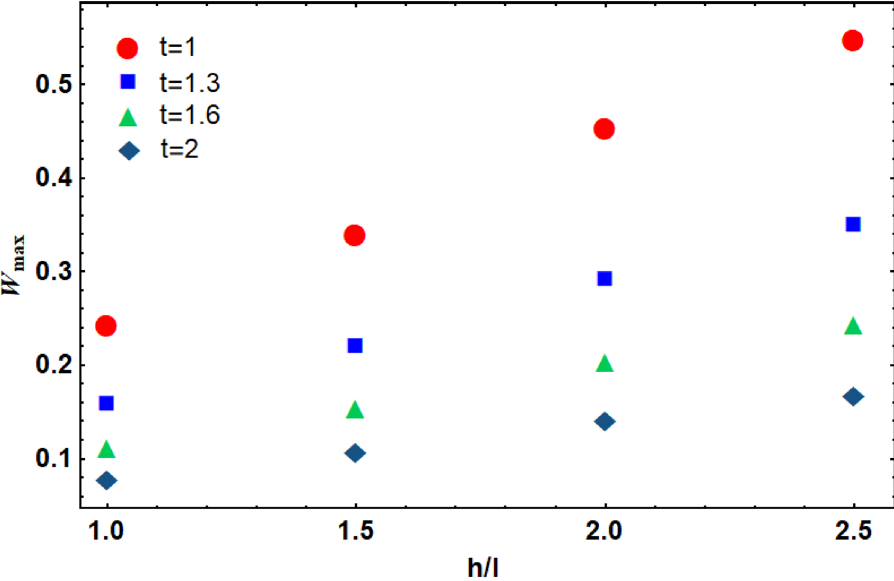
Figure 6. The maximum deflection of the sandwich plate by different thicknesses and lengths of an auxetic core lattice structure.